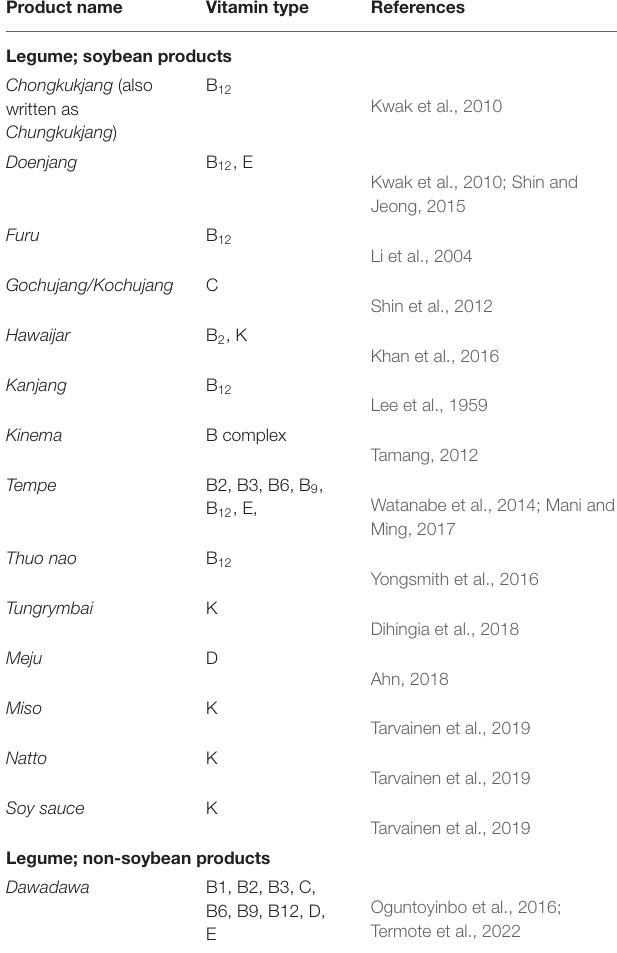
TABLE 3 | Improvement in vitamin availability of some